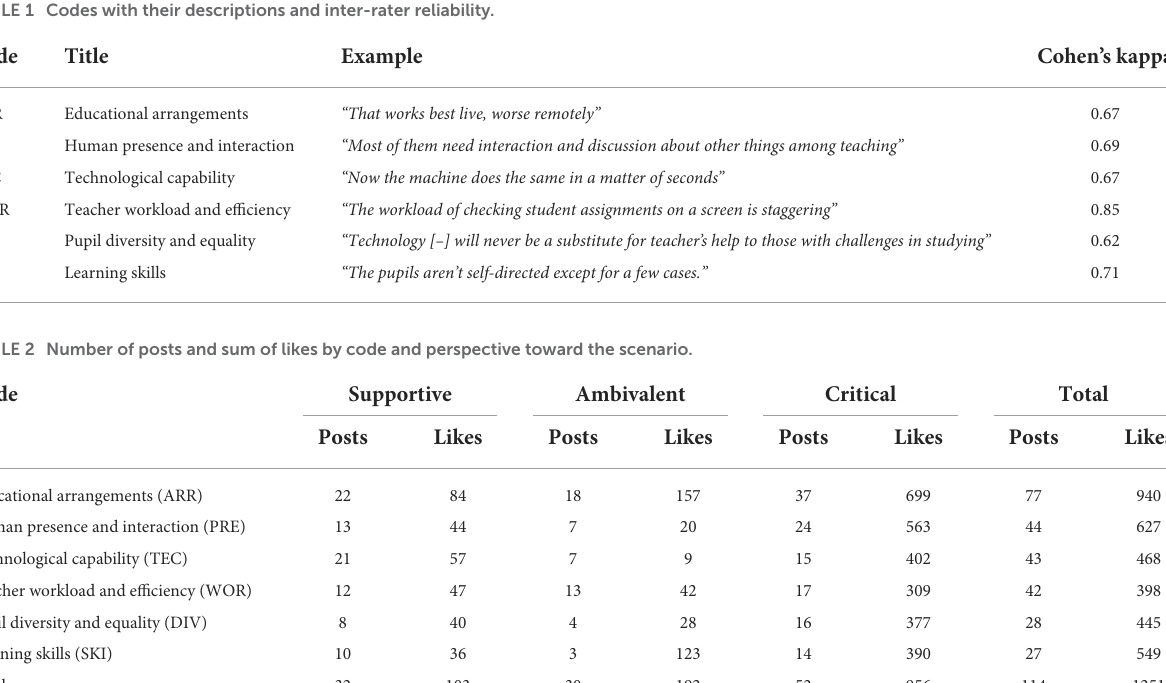
TABLE 1 Codes with their descriptions and inter-rater reliability.